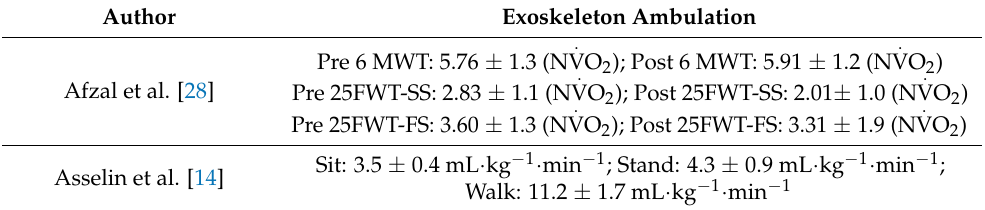
. Table 2. Mean VO 2 results (mL · kg − 1 · min − 1 , mL · kg − 1 km − 1 , L · min − 1 or mL) during exoskeleton assisted